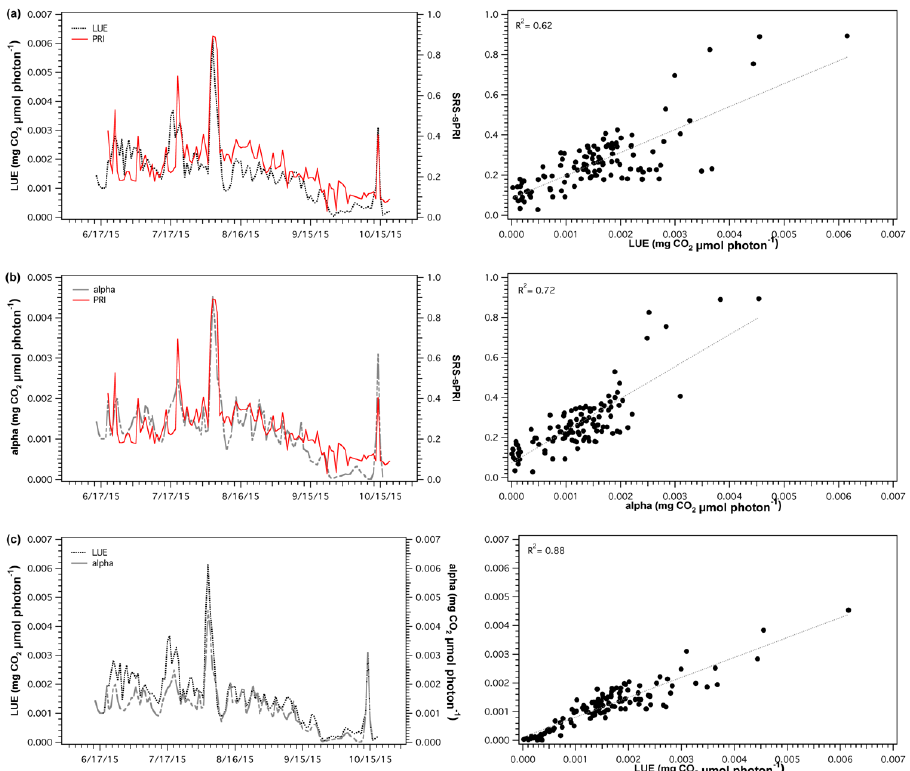
Figure 7. Time series (left panels) and regression plots (right panels) of ( a ) light use efficiency (LUE)